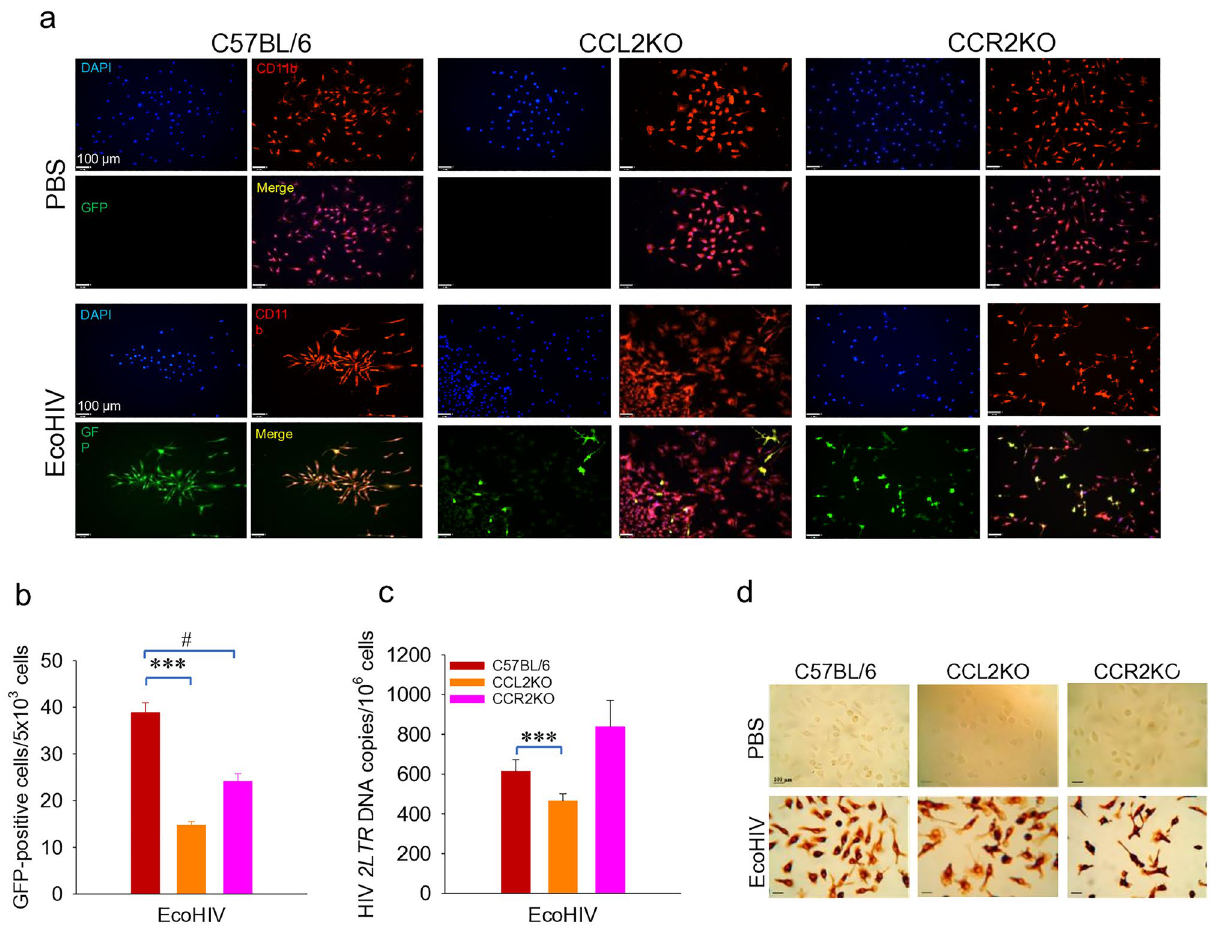
Figure 3. EcoHIV infection of BMM from C57BL/6, CCL2KO, and CCR2KO mice. See Methods for details. ( a ) Detection of EcoHIV-EGFP infected cells by fluorescence microscopy. EcoHIV-EGFP, green; CD11b, red; DAPI, blue; Merge, yellow. Scale bar = 100 μm. ( b ) Measurement of EcoHIV-EGFP expression by microscopy and image analysis. ***p < 0.001 C57BL/6 vs . CCL2KO, # p < 0.05 C57BL/6 vs . CCR2KO. ( c ) Measurement of 2-LTR DNA by QPCR. ***p < 0.001 C57BL/6 vs . CCL2KO. ( d ) Immunohistochemistry staining for HIV